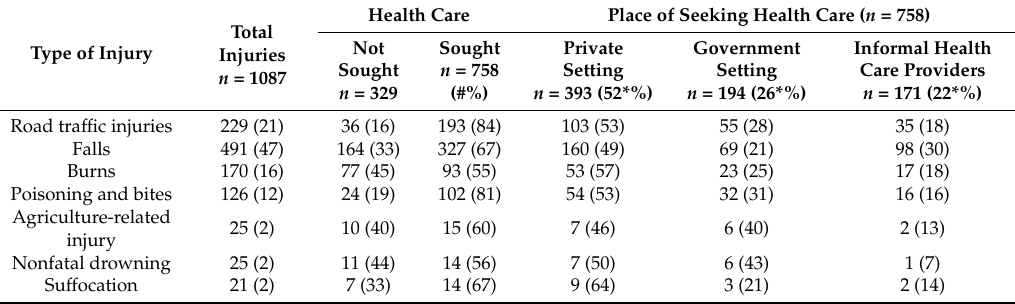
Table 3. Distribution of health seeking and the place of health seeking for 758 injuries.